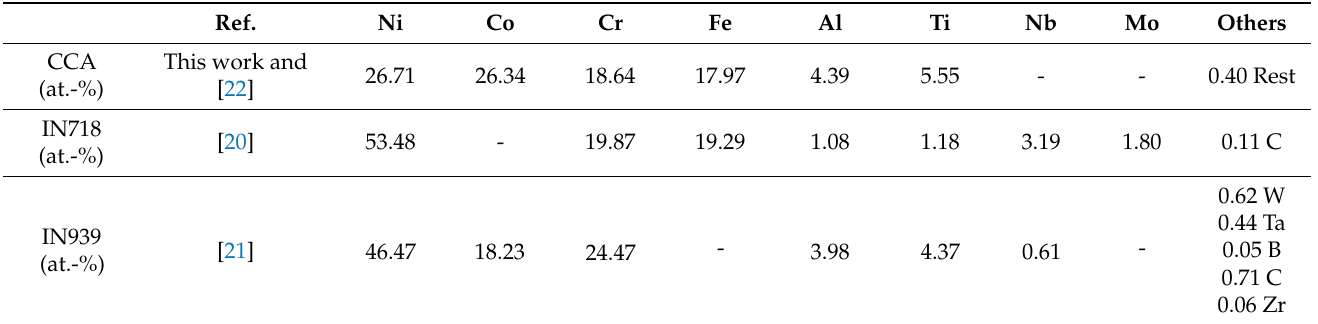
Table 1. Chemical alloy composition of the investigated CCA and the Ni-based alloys IN718 from [20] and IN939 from [21] in